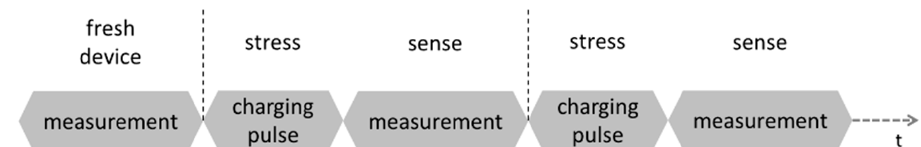
Figure 5. The measurement procedure which was implemented during the electrical characterization of investigated structures.